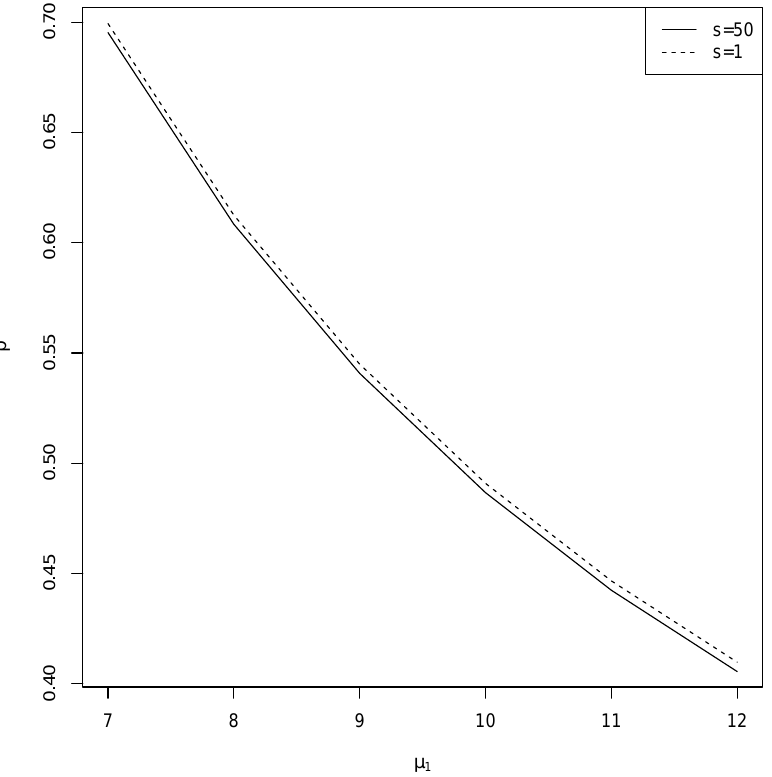
Figure 4. Dependency of ρ on µ 1 ∈ [ 7,12 ] for s = 1,50 and other parameters fixed: S = 100,